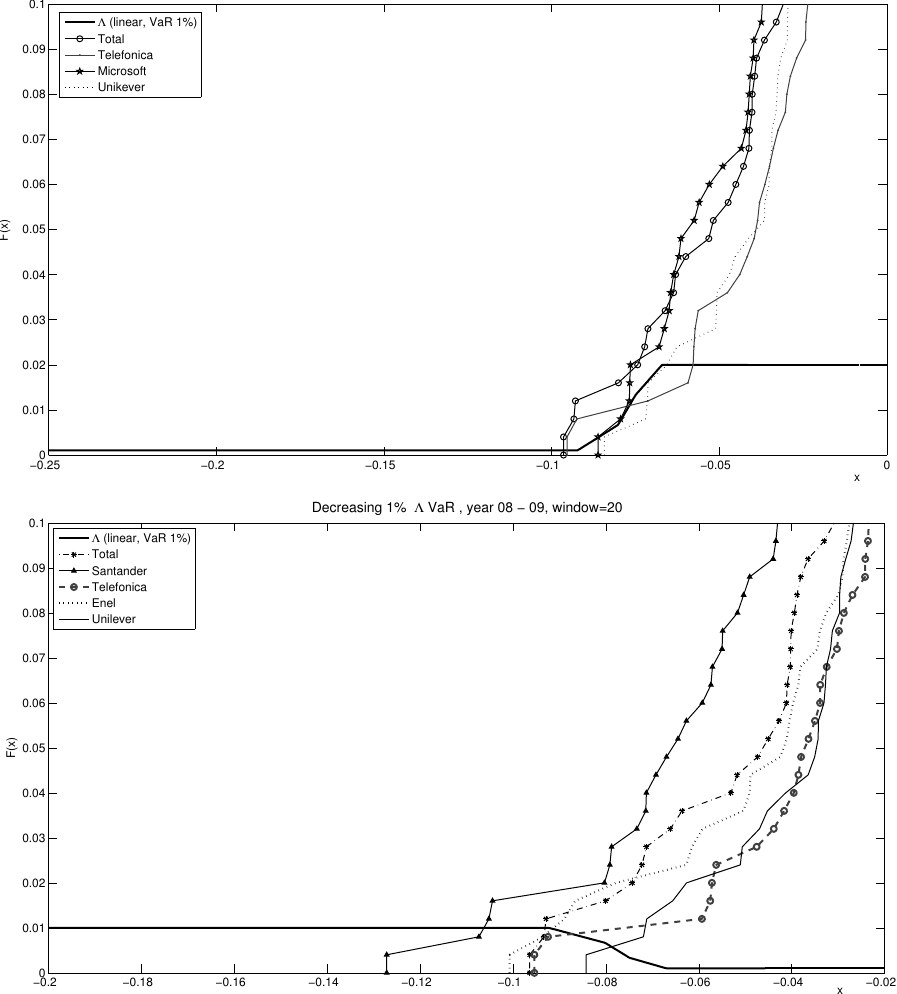
Figure 1. Increasing and decreasing Λ VaR . Λ VaR coincides with the smallest intersection between the P&L distribution and the Λ function. Λ VaR is able to capture different tail behaviour of return distributions better than VaR . For instance, in the figure on the top, Total has thicker tails than Microsoft. They have the same 2% VaR ( ∼ = 0.075) but Total’s 2% Λ VaR ( ∼ = 0.1) is higher than Microsoft’s 2% Λ VaR ( ∼ = 0.0875). In the figure at the bottom, the same happens for Telefonica and